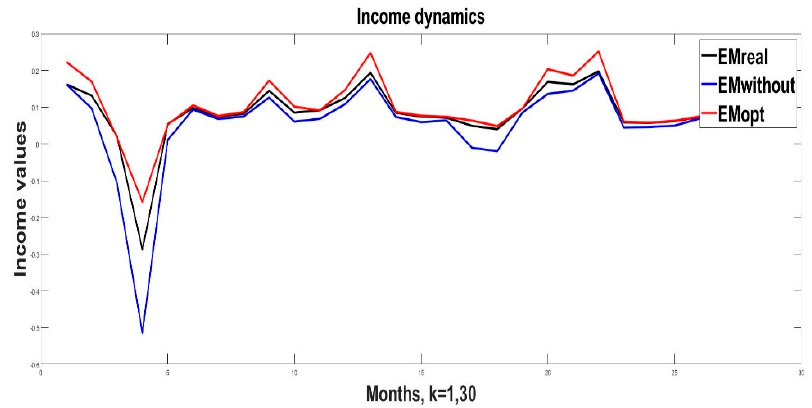
Figure 9. The behavior of the three categories of income 𝐸 (cid:3014)(cid:3050)(cid:3036)(cid:3047)(cid:3035)(cid:3042)(cid:3048)(cid:3047) , 𝐸 (cid:3014)(cid:3045)(cid:3032)(cid:3028)(cid:3039) , and 𝐸 (cid:3014)(cid:3042)(cid:3043)(cid:3047) .